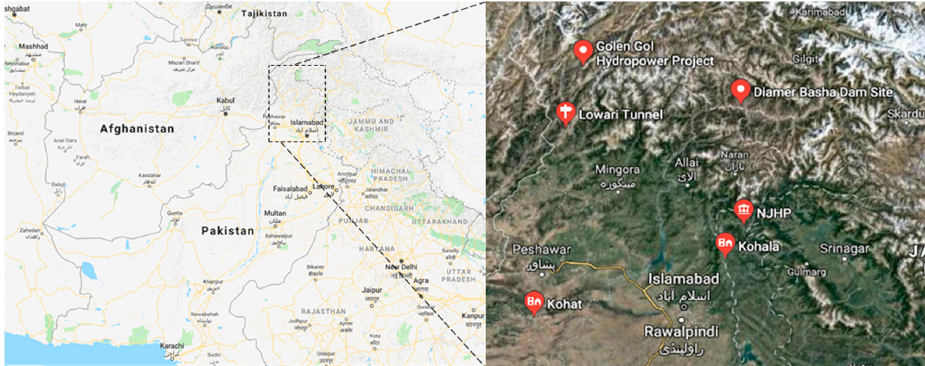
Figure 1. Location of the projects.